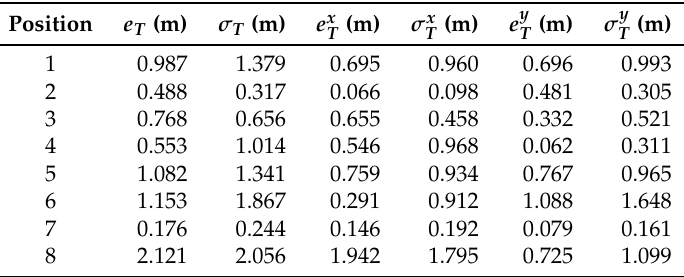
Table 3. Measured accuracy of the Two Stage Maximum Likelihood (TSML) algorithm in Scenario 2. Position